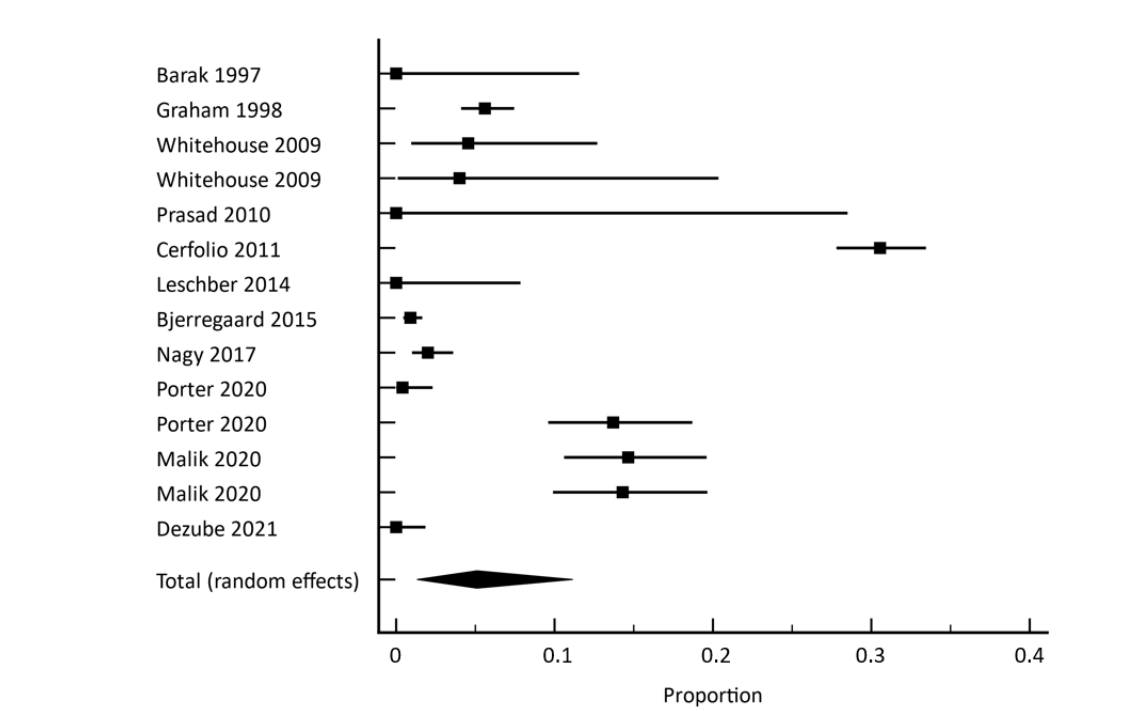
Figure 2. Forest plot of the meta-analysis. The relative frequency of a change in patient care for all included studies is presented with a 95% confidence interval. The diamond shows the result of the pooled analysis of the random effect model